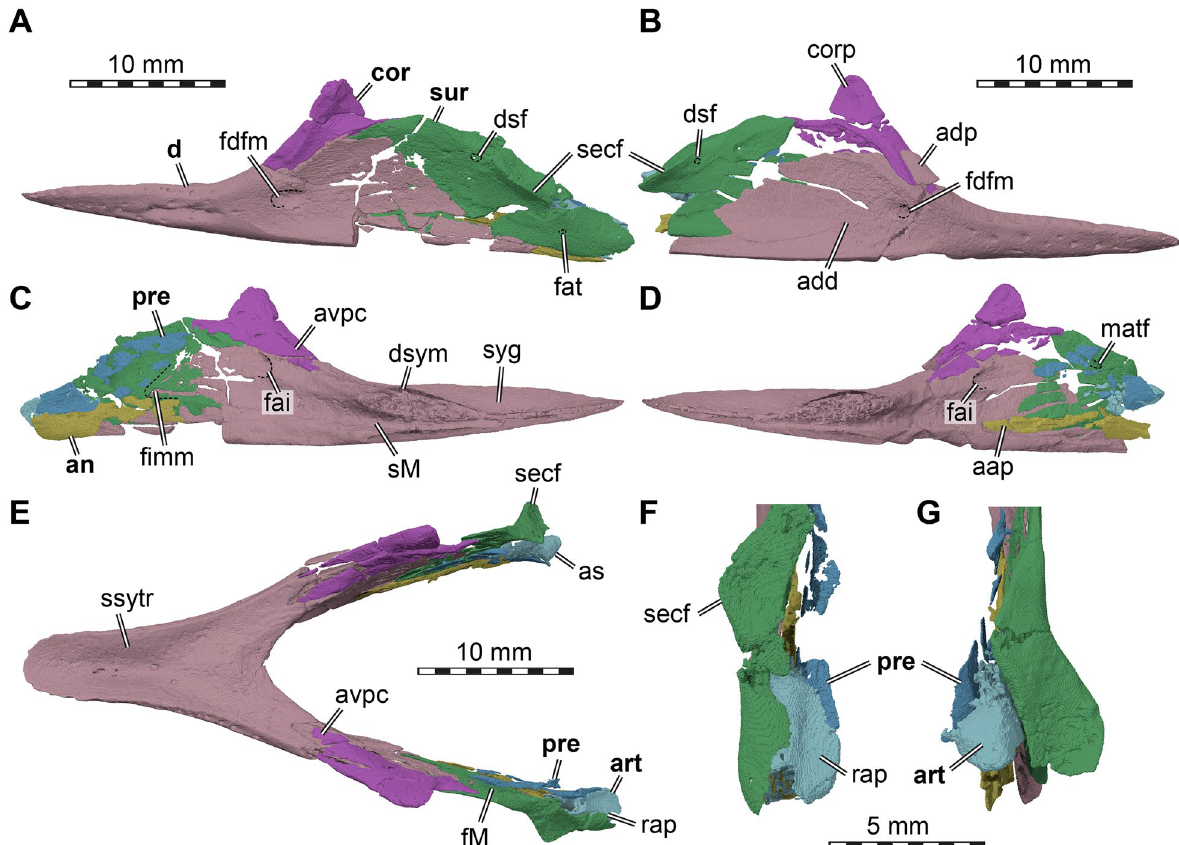
Fig. 11 Three dimensional renderings of the mandible of Plastomenus thomasii (AMNH FR 6015). A left lateral view; B right lateral view; C medial view of left mandibular ramus; D medial view of right mandibular ramus; E dorsal view; F posterodorsal view of posterior end of left mandibular ramus; G posterodorsal view of posterior end of right mandibular ramus. Medial views were achieved by artificially cutting the dentary along the symphysis. Note that bones are labelled in bold. Dashed lines circumscribe foramina to highlight their positions. aap anterior angular process, add adductor fossa, adp ascending dentary process, art articular, as articulation surface, cor coronoid, corp coronoid process, d dentary, dsf dorsal surangular foramen, dsym dorsal symphyseal mount, fai foramen alveolare inferius, fat foramen auriculotemporalis, fdfm foramen dentofaciale majus, fimm foramen intermandibulare medius, fM fossa Meckelii, matf medial auriculotemporal foramen, pre prearticular, rap retroarticular process, secf surangular ectocondylar flange, sM sulcus Meckelii, ssytr spatulate symphyseal triturating surface, syg symphyseal